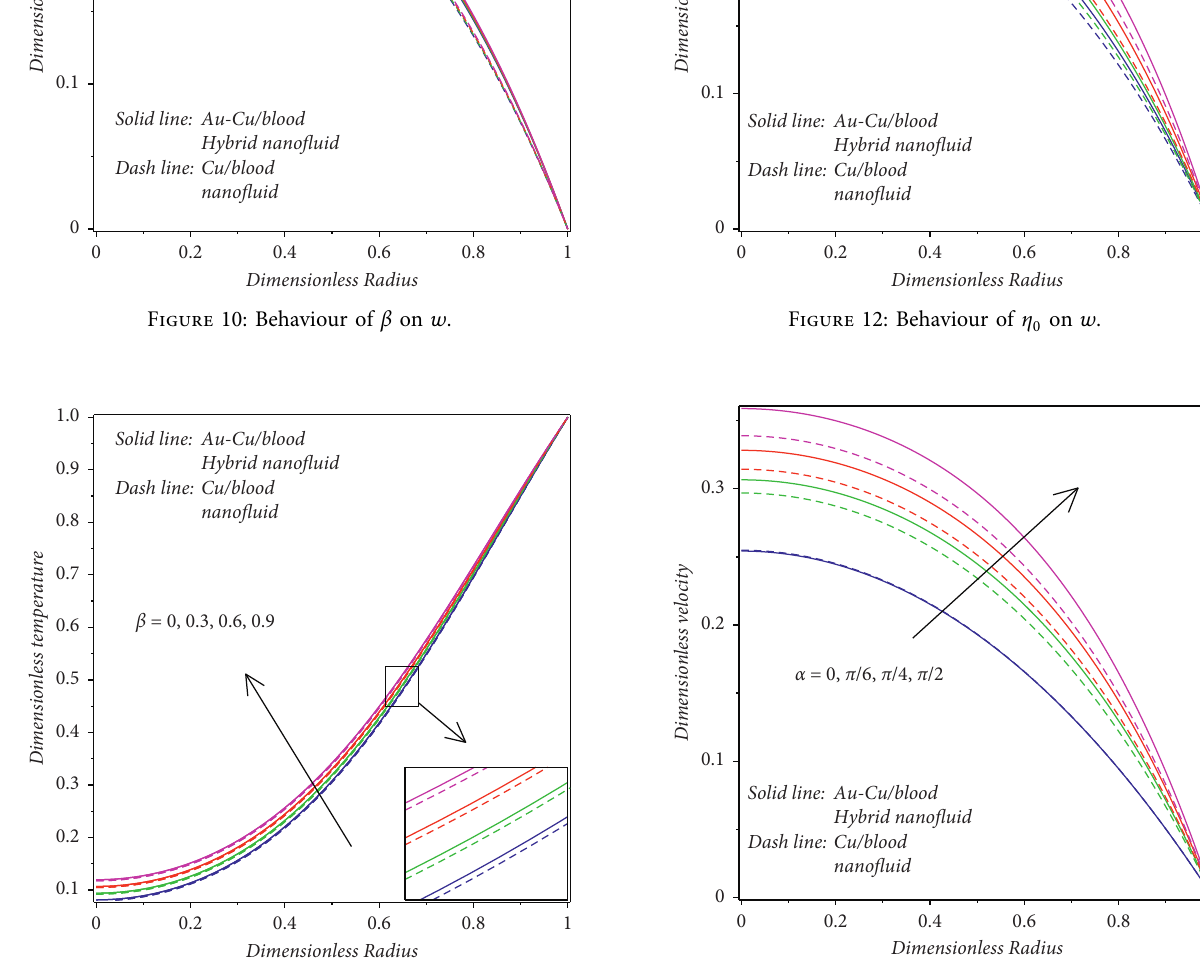
Figure 13: Behaviour of α on w .